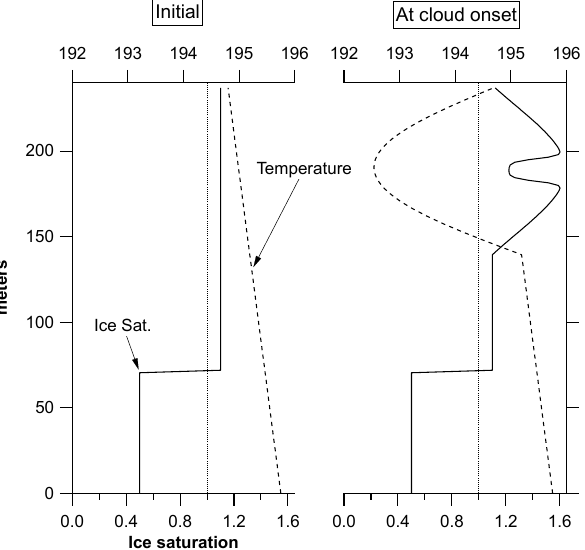
Figure 3. Vertical profiles showing how the one-dimensional model was initialized and cooling imposed. The imposed cooling used a smooth vertical profile over 100m but fluctuated in time. One can picture the half-sine temperature perturbation oscillation with an amplitude that followed one of the temperature trajectories in Fig.